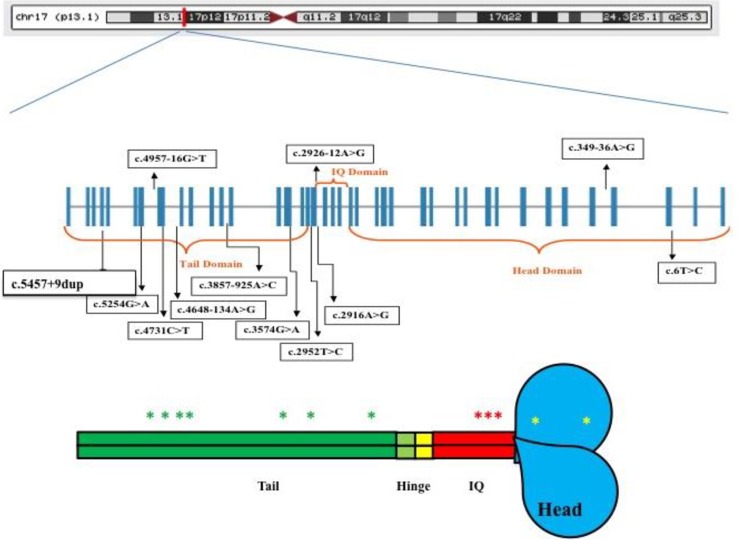
Genomic model of MYH3 and diagrammatic illustration of the spectrum of variants.(A) Position of MYH3 at Chromosome 17. (B) Boxes represent exons and adjoining lines represent introns. (C) Schematic representation of MYH3 domains with the approximate location of MYH3 variants indicated with coloured asterisk mark.